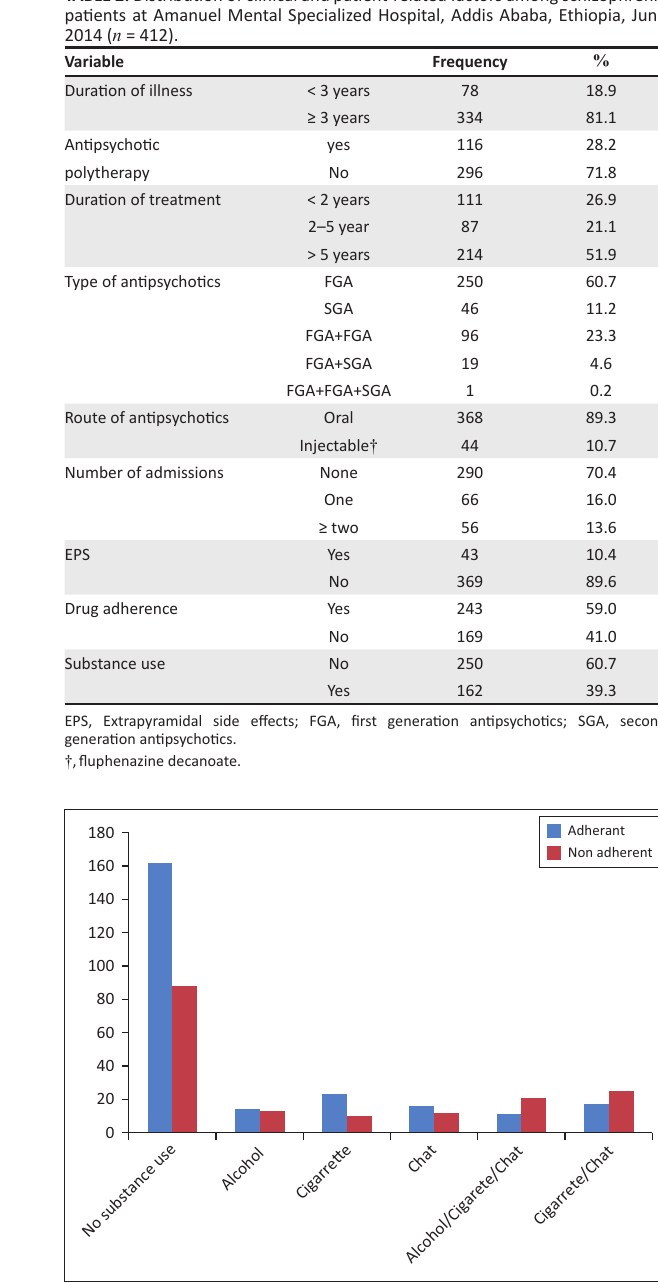
FIGURE 1: Bar chart showing the distribution of substance use among schizophrenia patients at Amanuel Mental Specialized Hospital, Addis Ababa, Ethiopia, June 2014 ( n =